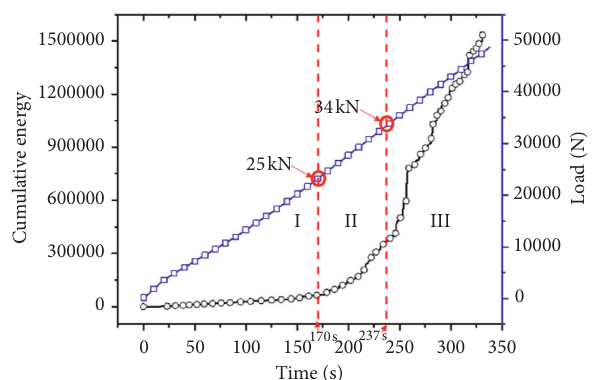
Figure 8: Load-time and AE cumulative energy-time curves for specimen ( L � 25mm).